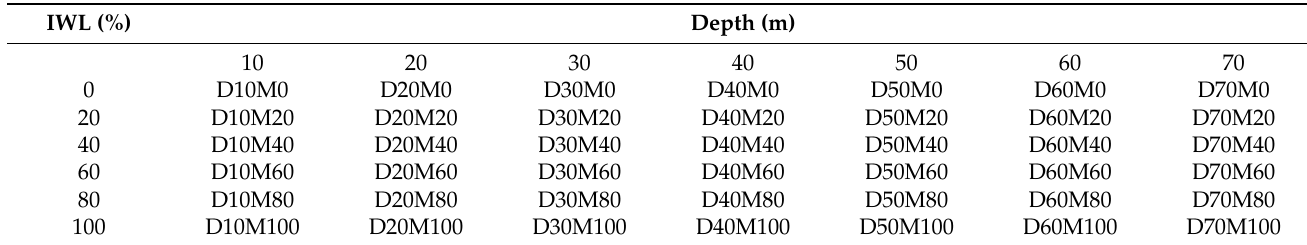
Table 6. Parameter setting (water depth for site & inner water level inside of